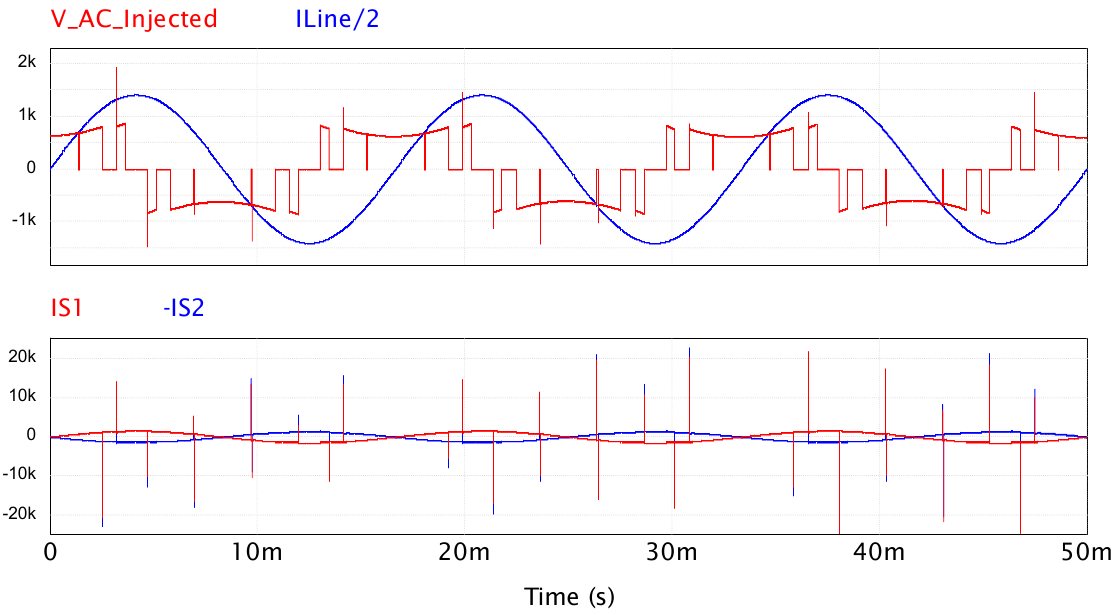
Figure 15. Repetition of case (d) from Figure 14 without balancing network.